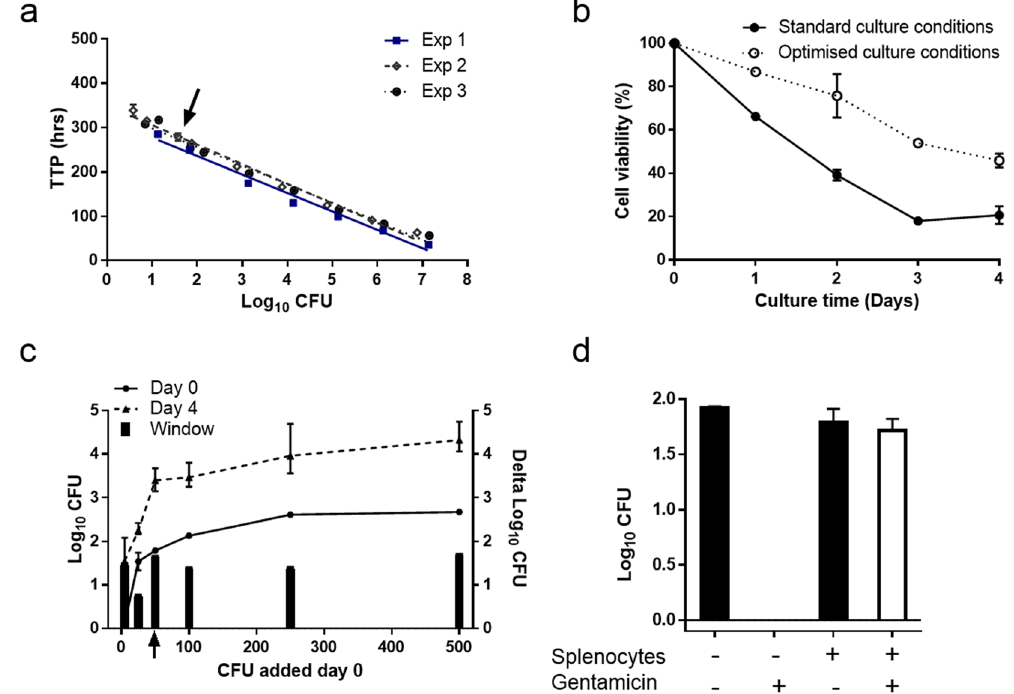
Figure 1. Assay optimisation and fundamental parameters in the splenocyte MGIA. ( a ) Results from three independent experiments (Exp 1, 2 and 3) in which serial 10-fold dilutions of M.tb Erdman were added MGIT tubes to produce a standard curve from which the time to positivity (TTP) could be related to inoculum size. Log 10 colony forming units (CFU) were determined by plating aliquots of M.tb Erdman on agar plates. Error bars represent mean ± range of measurements done in duplicates. ( b ) Cell viability of naive splenocytes cultured in standard media with rotation (standard culture conditions) or in enriched media without rotation (optimised culture conditions). Error bars represent mean ± range of duplicates measured of splenocytes pooled from three naive mice. The results are representative of three independent experiments. Similar viability was confirmed by manual nigrosine count. ( c ) Splenocytes from individual naïve mice were co-cultured in four days with 5, 25, 50, 100, 250 or 500 CFU of M.tb Erdman under optimised culture conditions (Day 4). The inoculums were directly transferred to MGIT tubes at day 0 to generate a baseline (Day 0). Error bars represent mean ± range of measurements done in duplicates (Day 0). Error bars represent mean ± range of one mouse measured in triplicates (25, 50, 250 and 500 CFU) or in four replicates (5 and 100 CFU) (Day 4). The window was calculated by subtracting the mean values at Day 0 from Day 4. ( d ) Splenocytes from naïve mice were co-cultured for three hours with 50 CFU of M.tb Erdman followed by one hour of 0 or 100 μ g/ml gentamicin treatment before they were inoculated in MGIT tubes. In parallel, samples without splenocytes were incubated. Error bars represent mean ± range of duplicates measured of splenocytes pooled from two